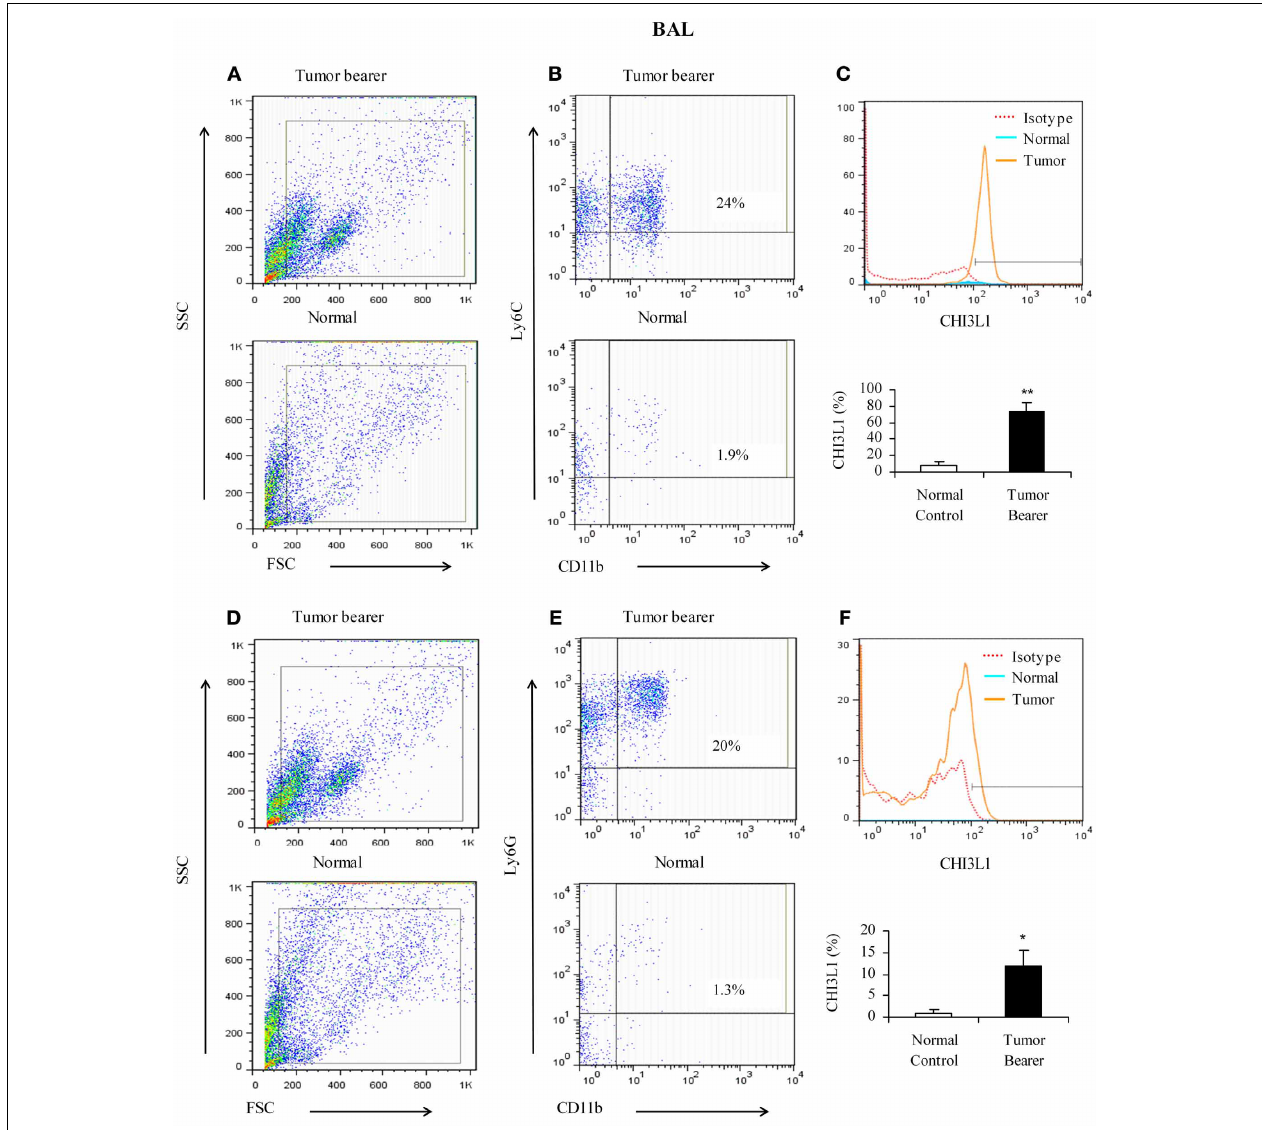
FIGURE 4 | CHI3L1 is expressed at higher levels in CD11b + Ly6C + bronchoalveolar lavage cells in 2-week mammary tumor bearers. (A,D) Representative scatter plots of forward scatter vs. side scatter in alveolar lavage from normal and tumor bearers; (B) CD11b + Ly6C + cells from alveolar lavage of normal and tumor bearers and assessed for CHI3L1 expression; (C)